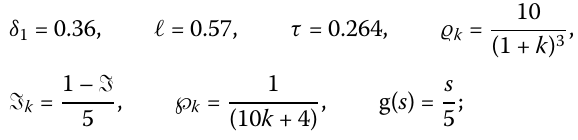
(4) Algorithm 1 (briefly, M-EGM